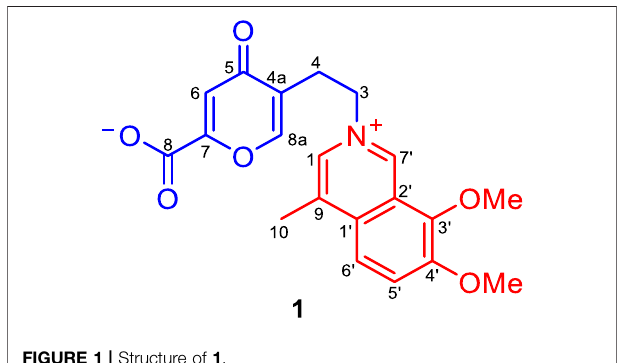
FIGURE 1 | Structure of 1